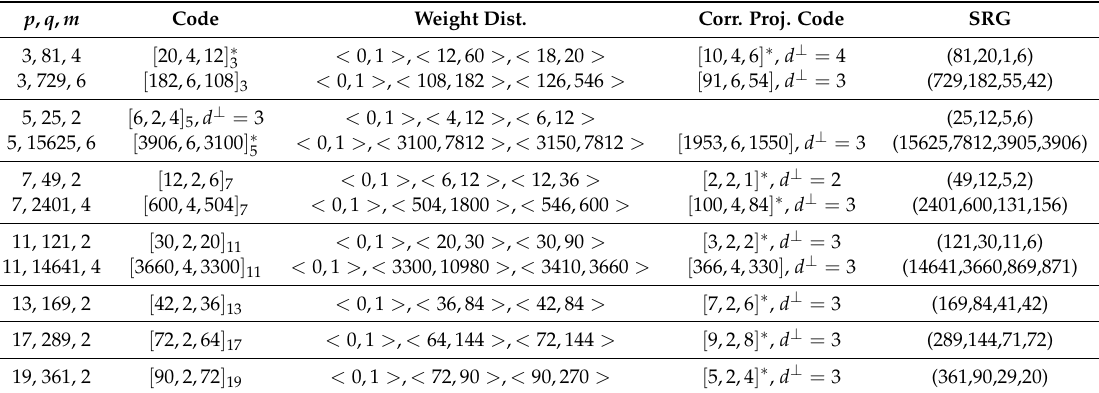
Table 3. Two-weight trace codes from powers of 4.